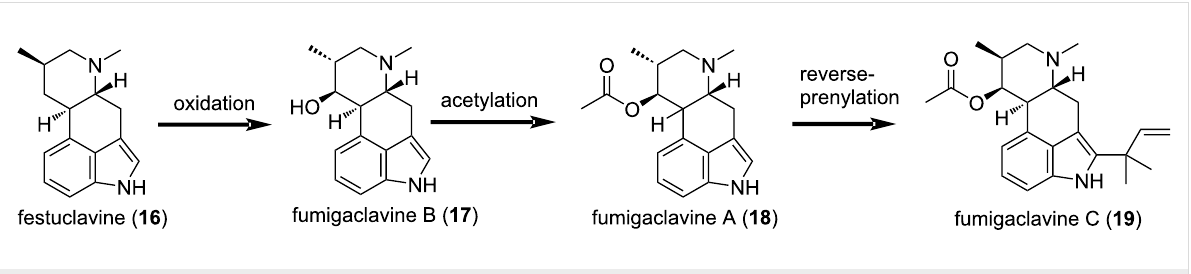
Figure 6: Intermediates and products of the fumigaclavine C